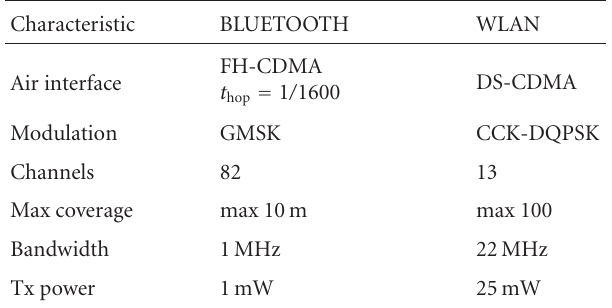
Table 1: Physical level characteristics of the Bluetooth and IEEE 802.11b